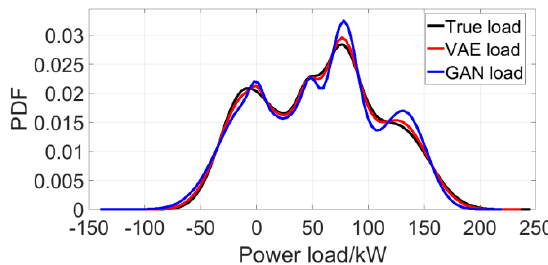
Figure 7. Probability density functions of true load and generated load.